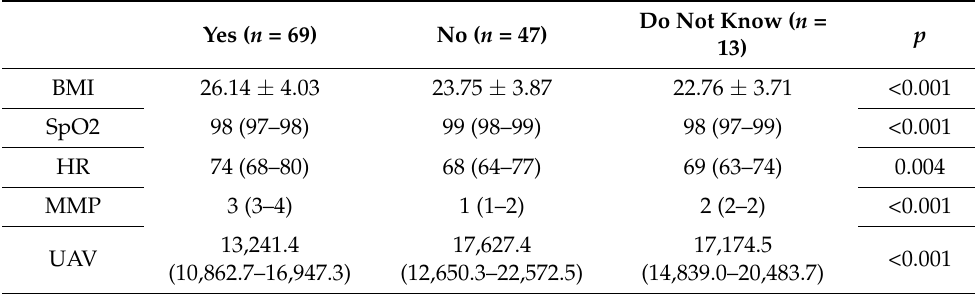
Table 1. Correlation between sex and mean age and BMI.